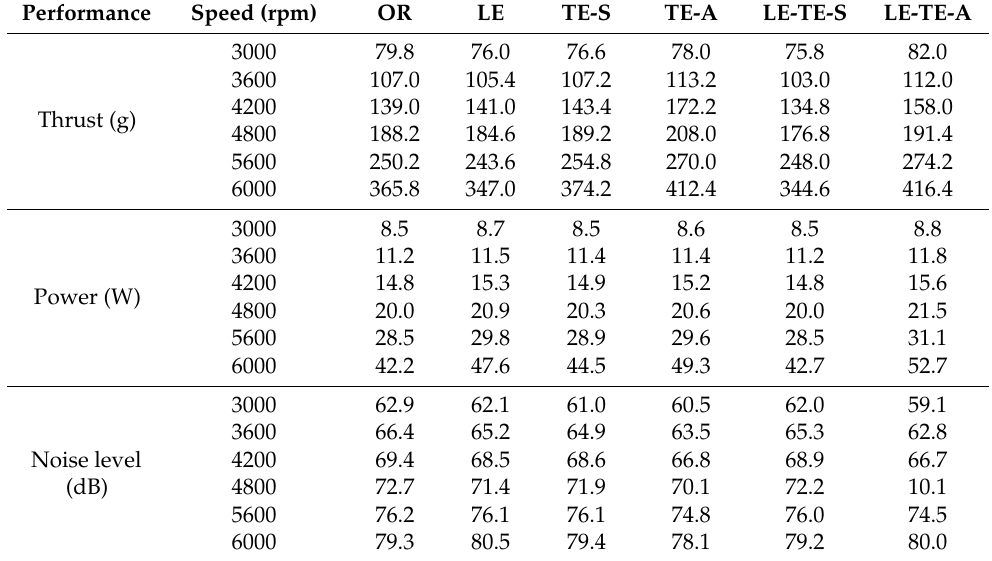
Table 7. Comparison on aerodynamic and acoustic performance of different rotors with Resin 9400 (rounding to the one decimal